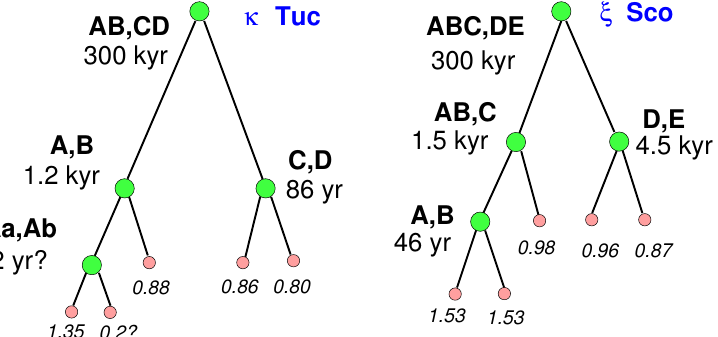
Figure 10. Hierarchical structure of two wide nearby quintuple systems κ Tuc and ξ Sco. Periods of the subsystems (green circles) and masses of the stars (pink circles) are